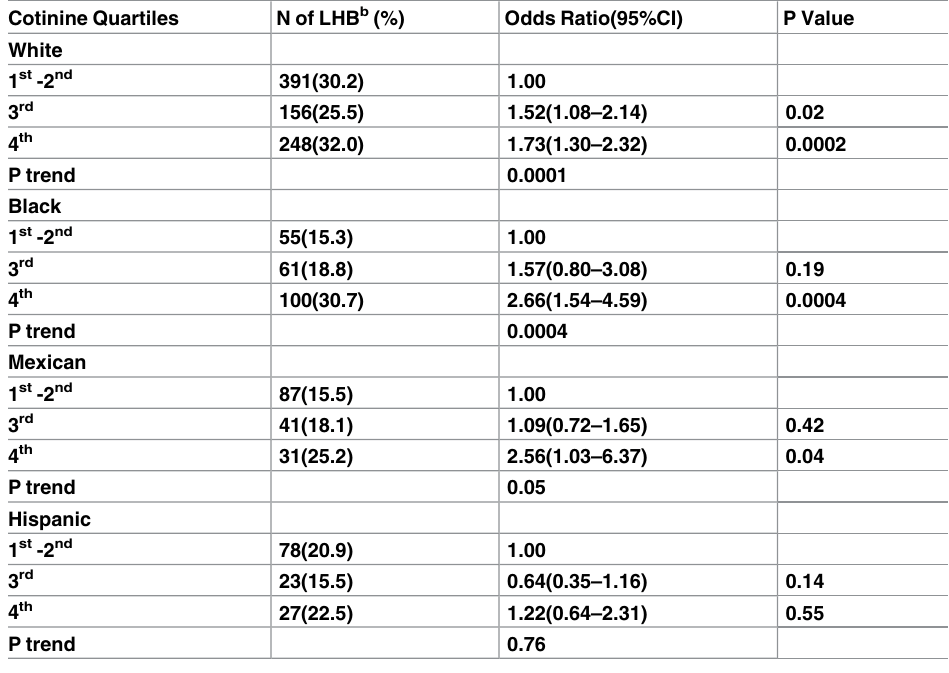
Table 4. Associations of quartiles of cotinine with HOMA-B further adjusted for HOMA-IR by race/